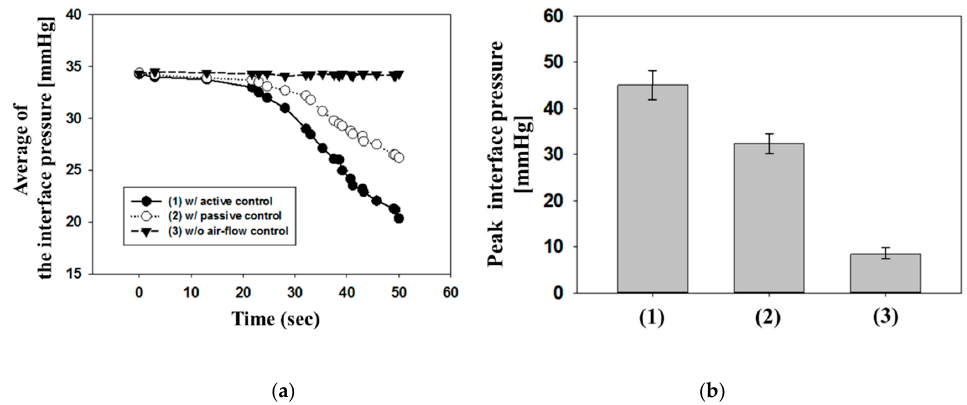
Figure 11. ( a ) The changes of the average pressure in a length of air cell over time and ( b ) peak pressure values at ToF sensor position at different air-flow controls of (1) without any air-flow control, (2) with a passive air-flow control, and (3) with an active air-flow control. The pressure relieving effect was confirmed by investigating the interface pressure with commercial equipment X3Pro when a participant was taking a supine posture on the air-filled cells.